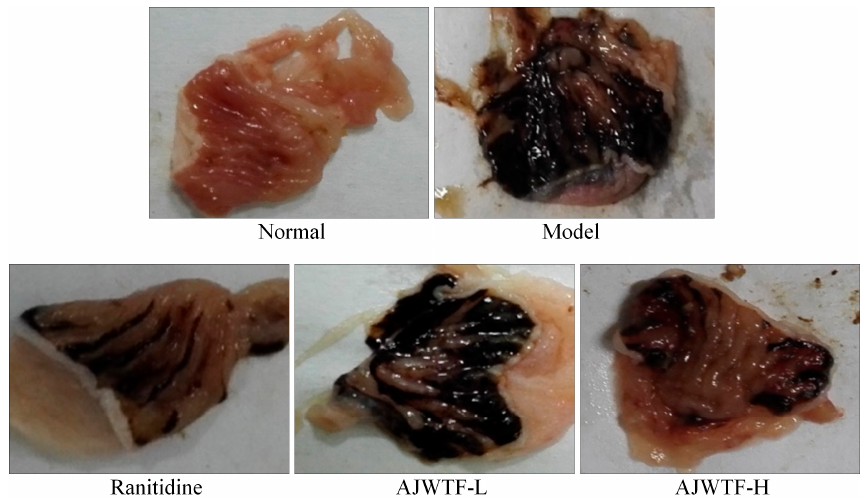
Figure 1. Stomach specimens of mice from each group. Ranitidine: Ranitidine at 50 mg/kg body weight (b.w.) by gavage; AJWTF-L: Anji white tea flavonoids at 100 mg/kg b.w. by gavage; AJWTF-H: Anji white tea flavonoids at 200 mg/kg b.w. by gavage. Table 3. Degrees of gastric injury in mice of each group ( n =